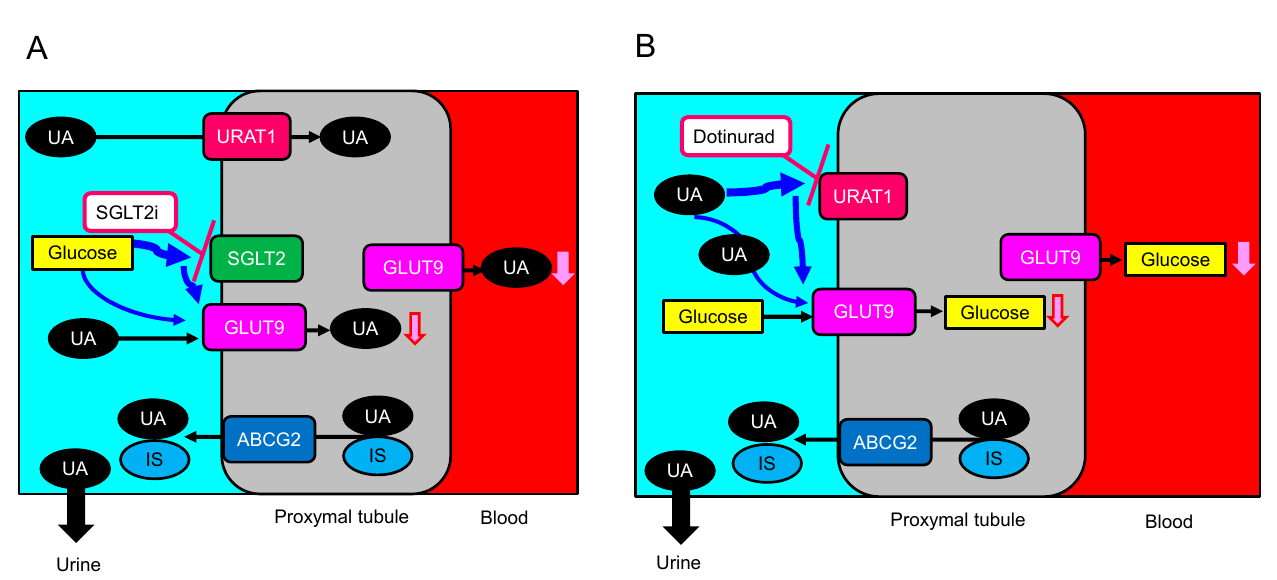
Figure 8. Crosstalk among UA transporters and glucose transporters, induced by SGLT2i ( A ) and dotinurad ( B ). ABCG2, ATP-binding cassette, subfamily G; GLUT9, glucose transporter 9; IS, indoxyl sulfate; SGLT2i, sodium-glucose cotransporter 2 inhibitors; UA, uric acid; URAT1, urate transporter 1.